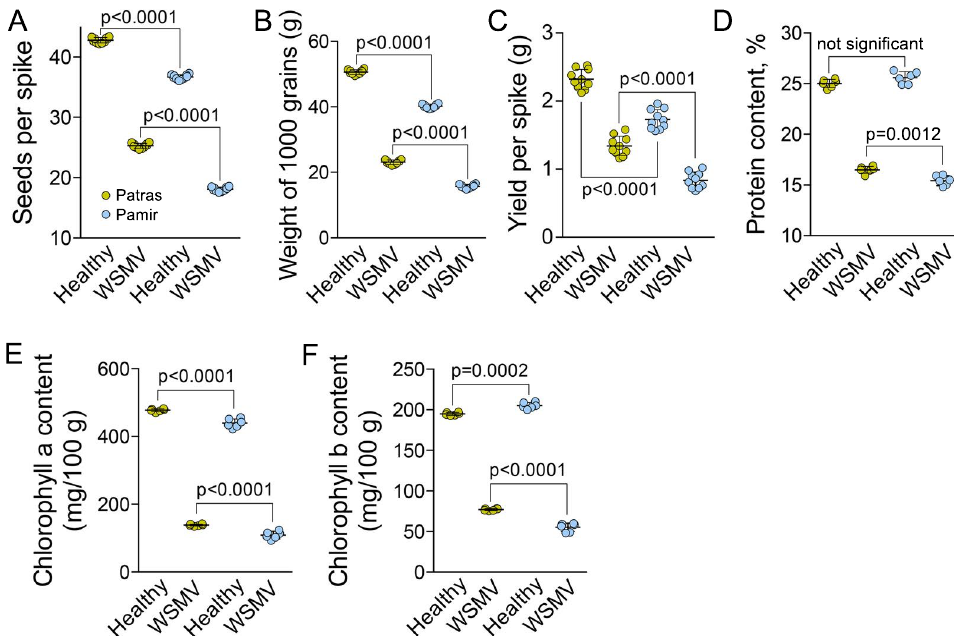
Figure 2. Impact of WSMV infection on yield and chlorophyll content. ( A ), Average seed number per spike in healthy and WSMV-infected plants. ( B ), Average weight of 1000 grains of healthy and WSMV-infected plants ( C ), Average weight of grains per spike in healthy and WSMV-infected plants ( D ), Relative protein content in leaves of healthy and WSMV-infected plants. ( E , F ), Chlorophyll a ( E ) and Chlorophyll b ( F ) content in leaves of health and WSMV-infected plants per 100 g of fresh leaf weight. Ten biological replicates (individual plants) were measured in A and six biological replicates (individual plants) were measured in ( D – F ). p values were calculated using non-paired t-test.